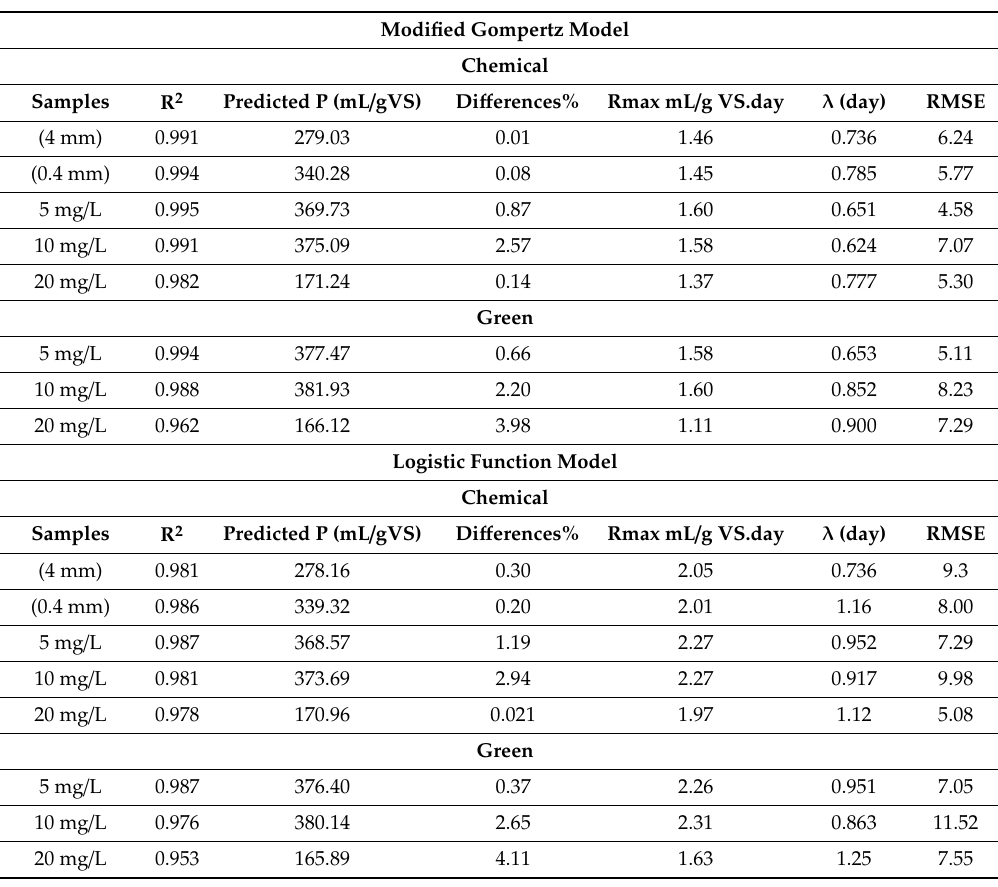
Table 7. Results of the kinetic study using the modified Gompertz and logistic function models.